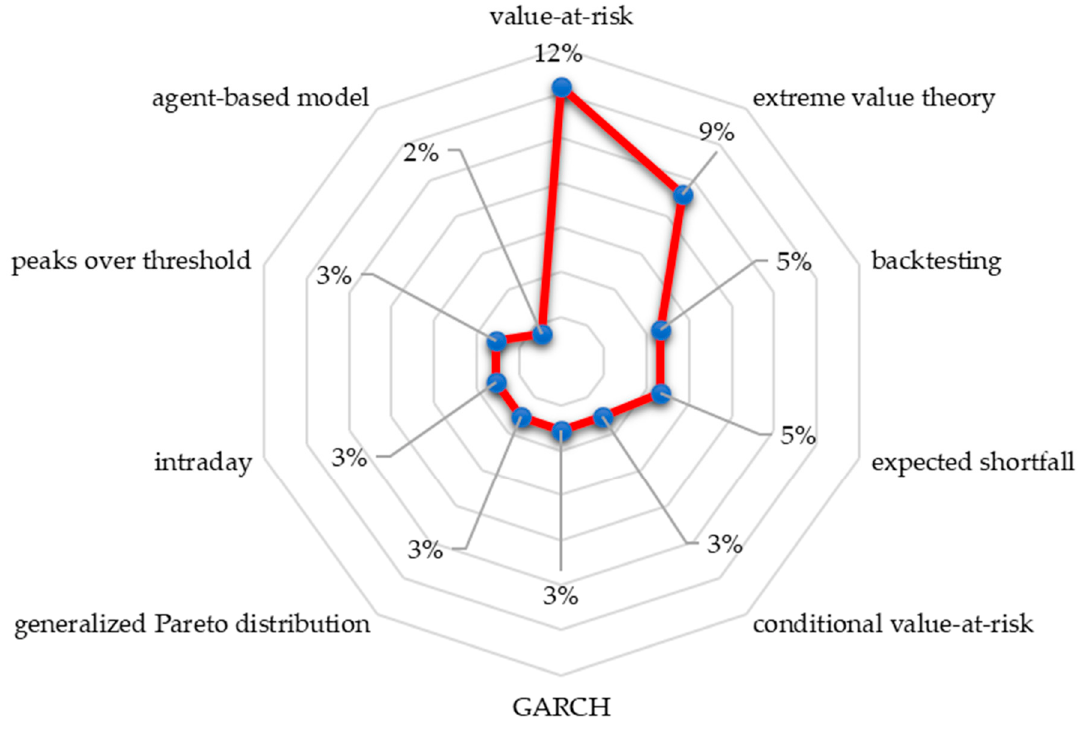
Figure 6. The 10 most commonly used keywords.